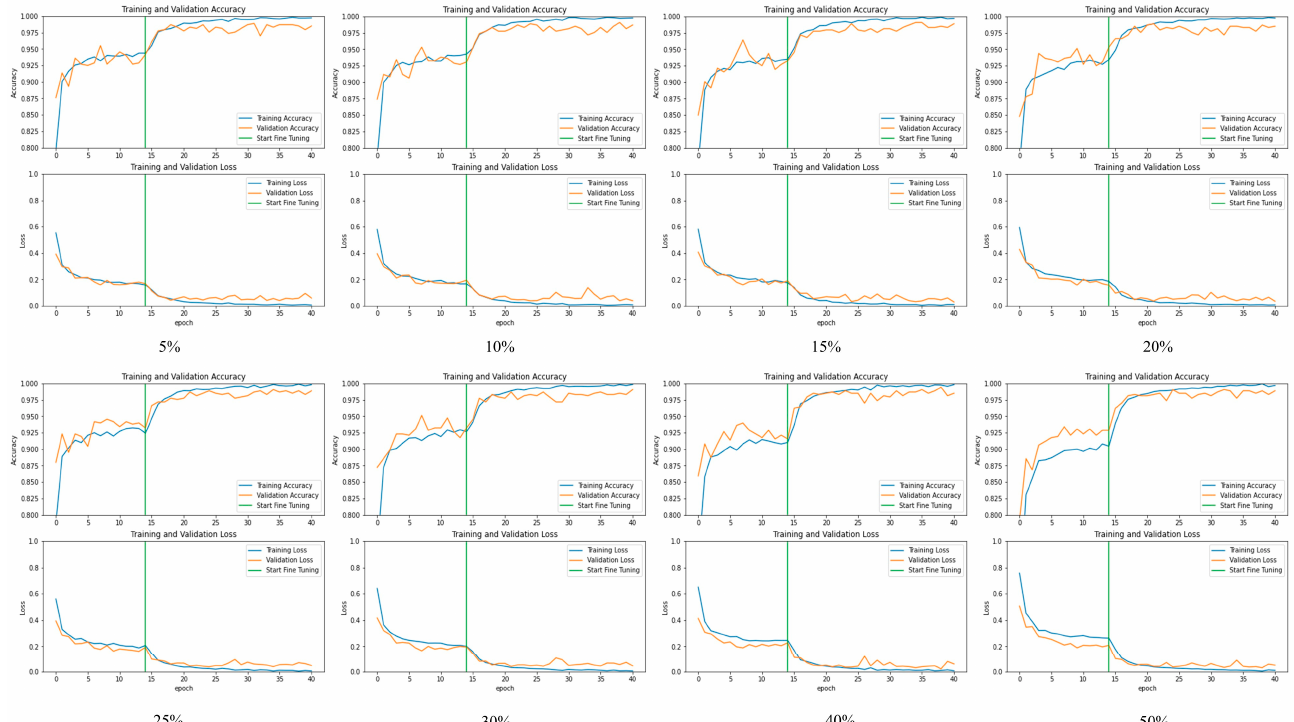
Figure 7. The relationship between accuracy and loss with the number of epochs for the dataset before and after fine-tuning the Inception V3 model with 5%, 10%, 15%, 20%, 25%, 30%, 40%, and 50% dropout values.